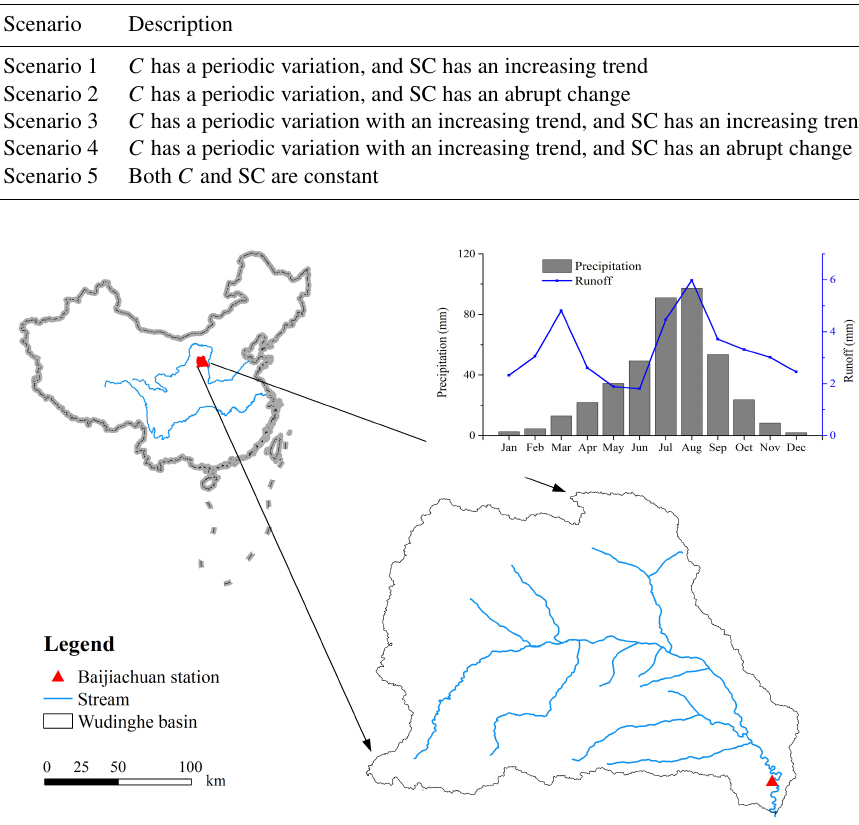
Table 2. Different variations of model parameters in the synthetic experiment.